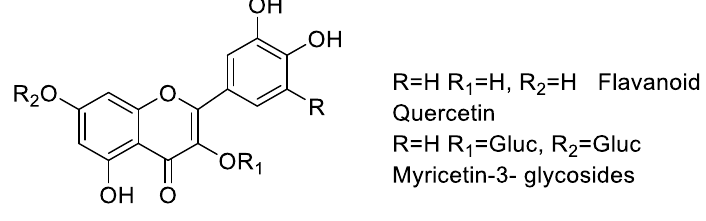
Figure 10. Flavonoids of Bridelia extract.